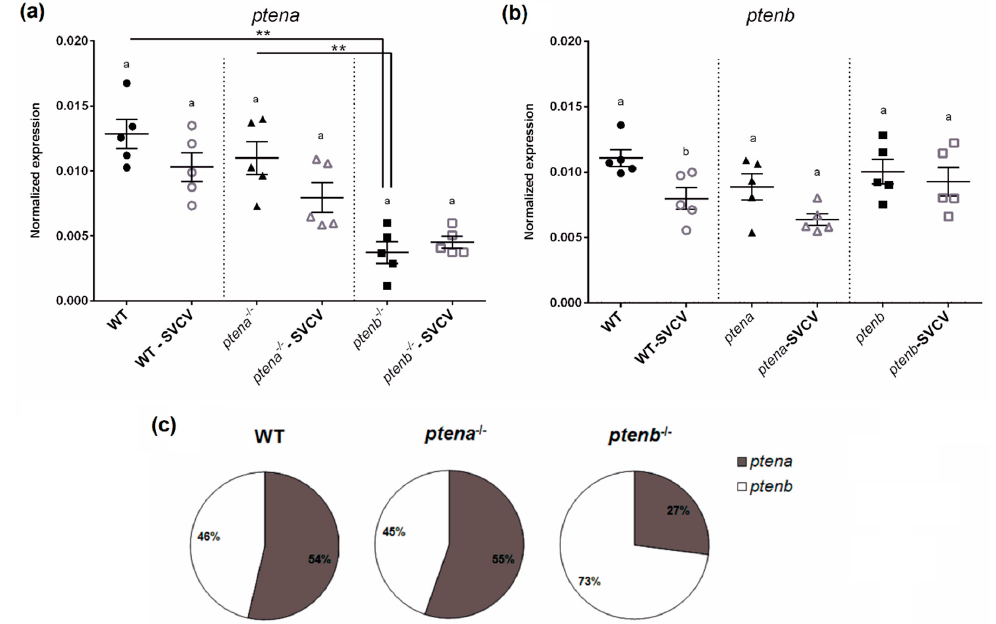
Figure 1. Gene expression of ptena and ptenb in zebrafish larvae. The expression of the ptena ( a ) and ptenb ( b ) genes in healthy wild-type, ptena -/- , and ptenb -/- zebrafish larvae and at 24 h after a Spring viremia of carp virus (SVCV) challenge. The expression of the different genes was normalized to the expression of the 18S ribosomal RNA gene. The graphs represent the means ± standard error means (SEMs) of 5 biological replicates. Statistically significant di ff erences between uninfected and SVCV-infected individuals from the same zebrafish line are represented with di ff erent letters, whereas di ff erences among the zebrafish lines are represented with asterisks as follows: ** (0.001 < p < 0.01. ( c ) mRNA proportion of the pten genes in the healthy larvae from the three zebrafish